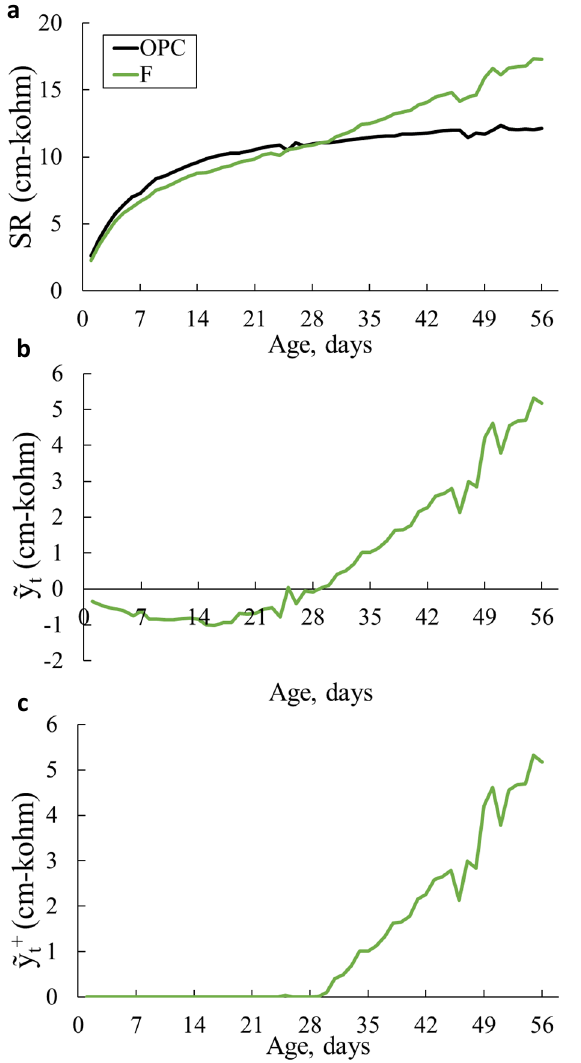
Figure 9. (a) Unprocessed surface resistivity time ‐ series results for mixtures OPC and F, cured at 23°C. (b) Processed residual surface resistivity values between mixtures OPC and F. (c) Processed residual surface resistivity values from 1b to ensure that only positive change ‐ points are considered for mixture F in change ‐ point detection analysis [32].